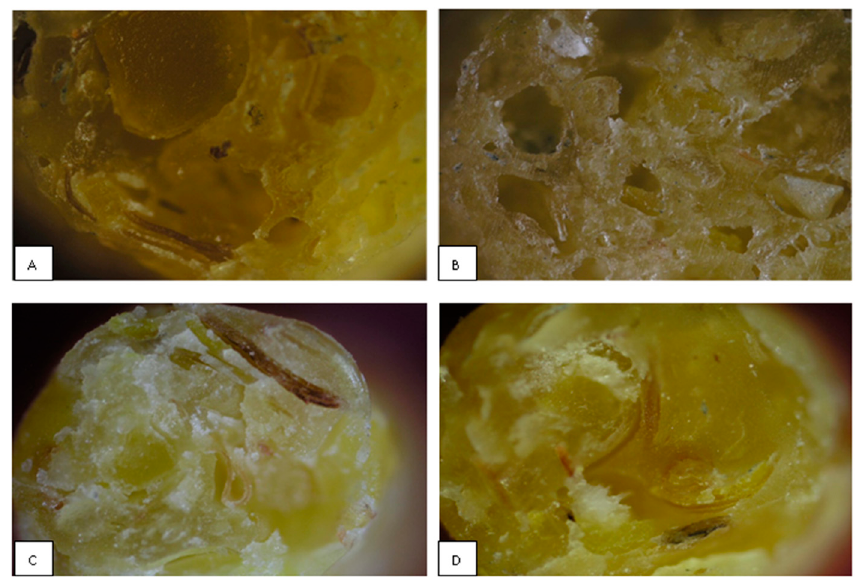
Figure 13. Microscopic photos of extruded corn bran processed at an extruder screw speed of 110 rpm and at: ( A ) 20% moisture level, ( B ) 25% moisture level, ( C ) 30% level of hydration and ( D ) 35% moisture level.